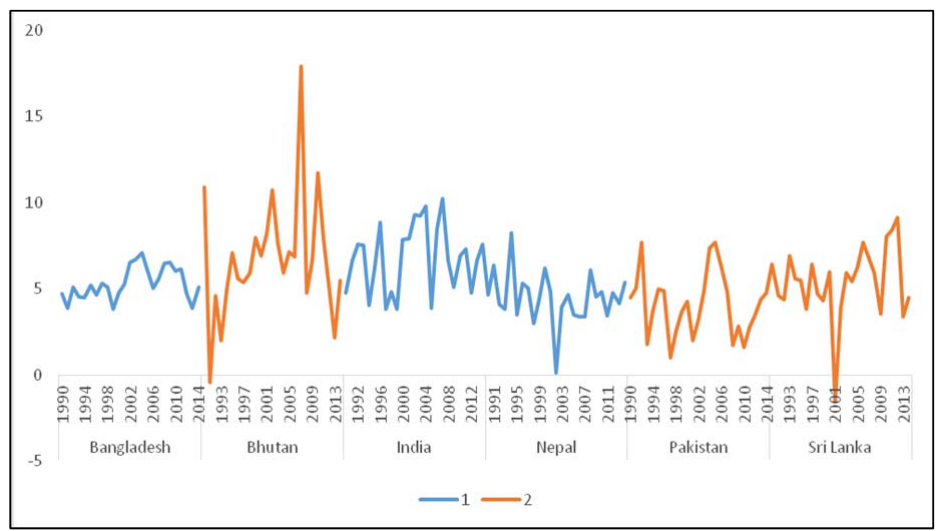
Figure 1. Growth (%) statistics of South Asia